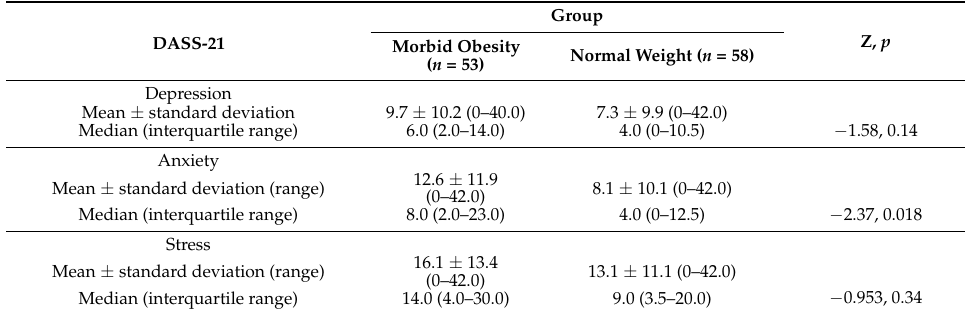
Table 4. Levels of depression, anxiety and stress scores on the DASS-21 in participants with morbid obesity compared to participants of normal weight.